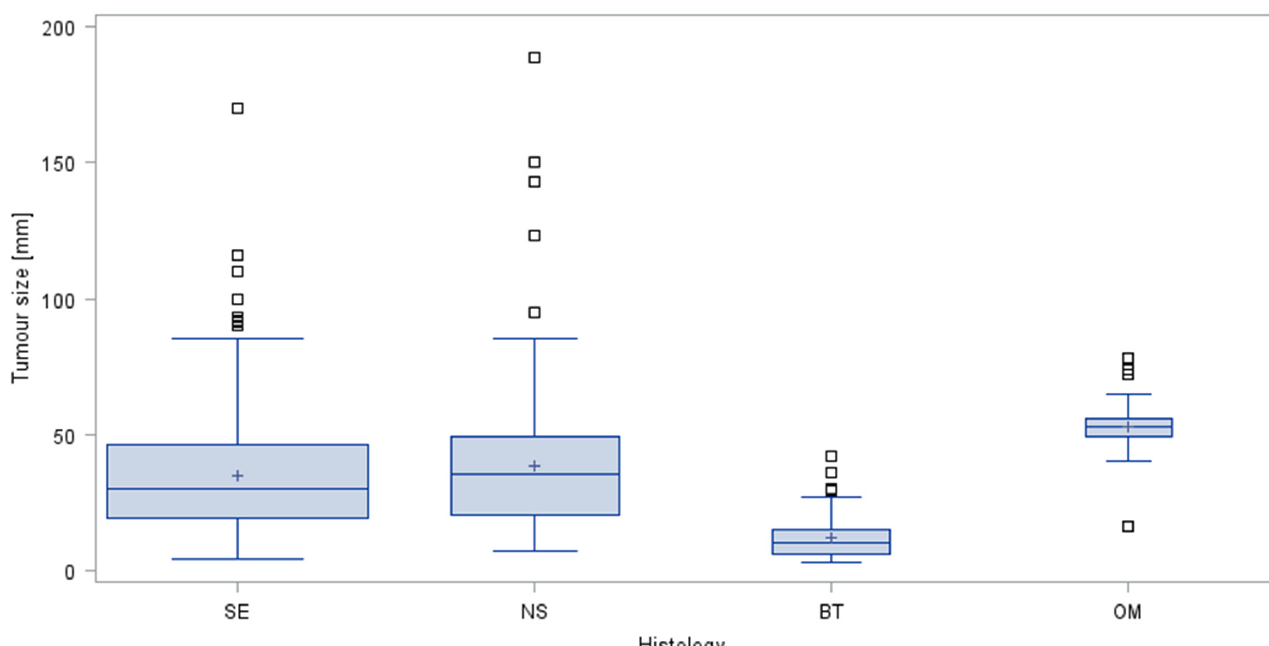
Figure 1. Tumour sizes observed in the four histologic groups. Box and whisker plots showing the distribution of tumour sizes stratified by histologic subtypes of testicular neoplasms. The boxes display the first quartile, median and third quartile. The whiskers are defined as the largest or lowest observed value that falls within 1.5 times the interquartile range measured from Q3 or Q1, respectively. Area of box relates to sample size. outliers; + denotes arithmetic mean; SE seminoma; NS nonseminoma; BT benign tumours; OM other malignancies.